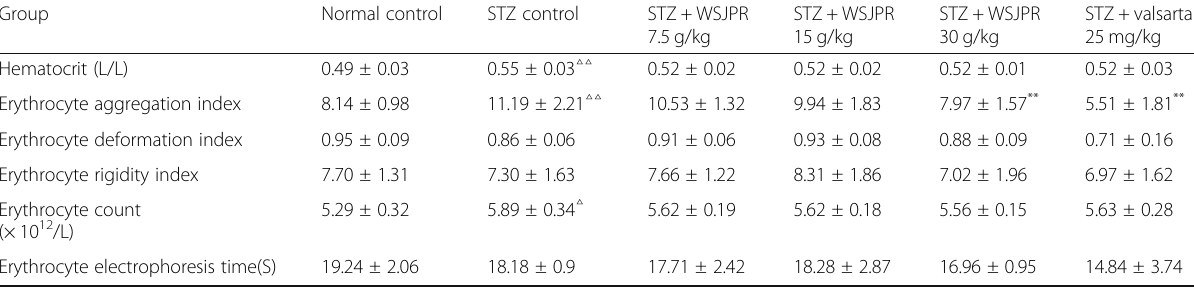
Table 2 Hemorheology indexes analysis in rats of each group (mean ± SD, n = 8) Group